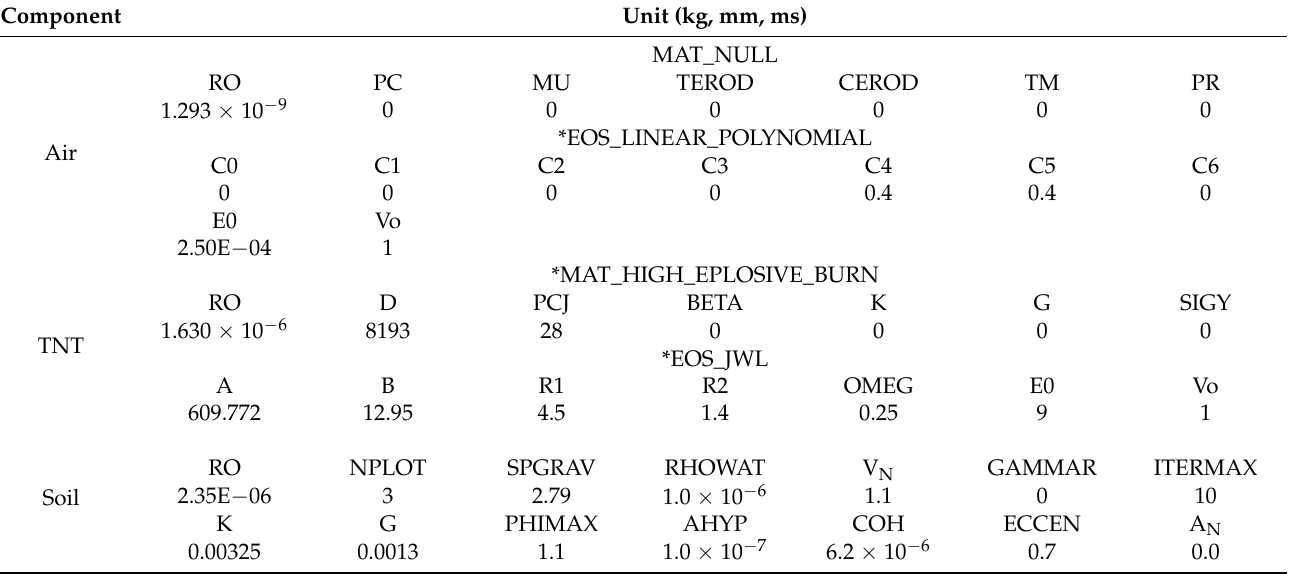
Table 5. Materials properties of air, TNT and soil